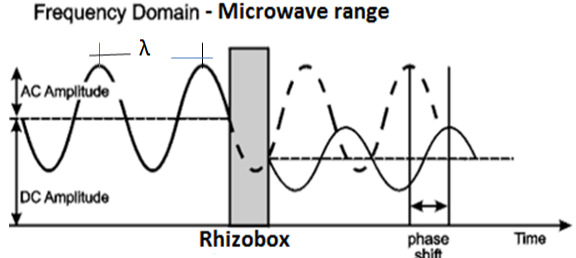
Figure 1. Diagram with the basic principle of the electromagnetic wave interactions with a rhizobox filled by a porous medium (attenuation and phase shift; modified from